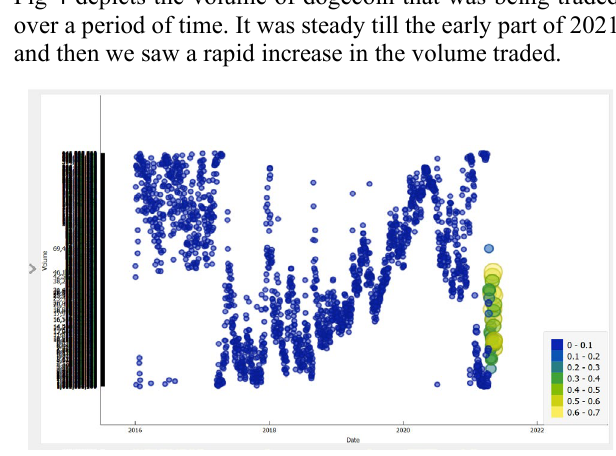
Fig. 4. Data Visualization of Volume of